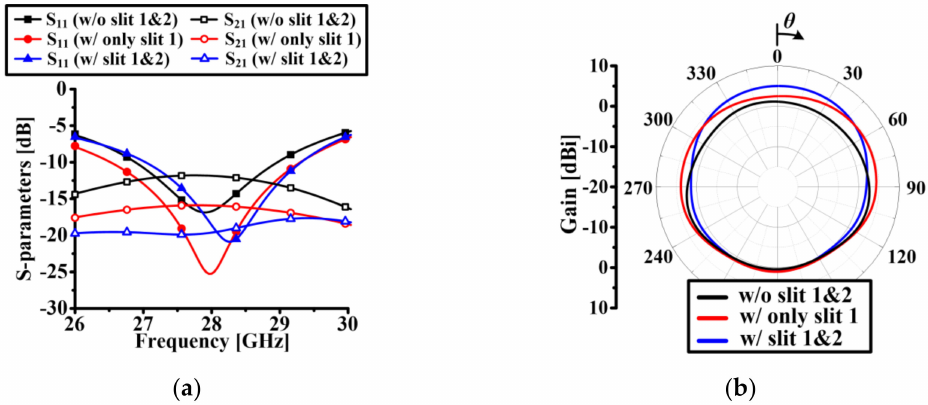
Figure 12. Simulated performances of the 1 × 2 array antenna with directors considering slits: ( a ) with S-parameters, and ( b ) showing the radiation patterns in the xz plane at 28